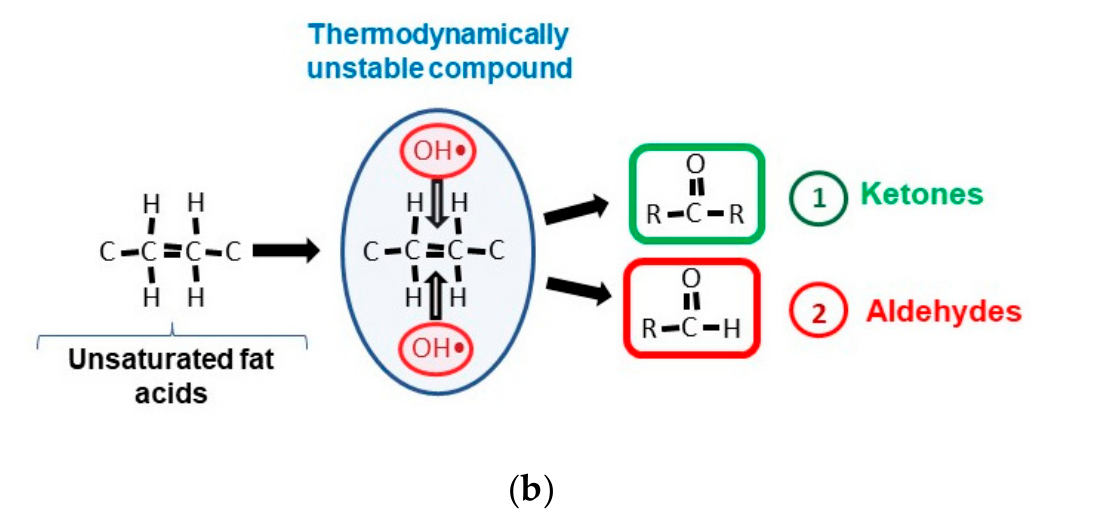
Figure 2. Simplified diagrams of formation of aldehydes and ketones as products of alcohol oxidation ( a ), and by decomposition of thermodynamically unstable compound ( b ).